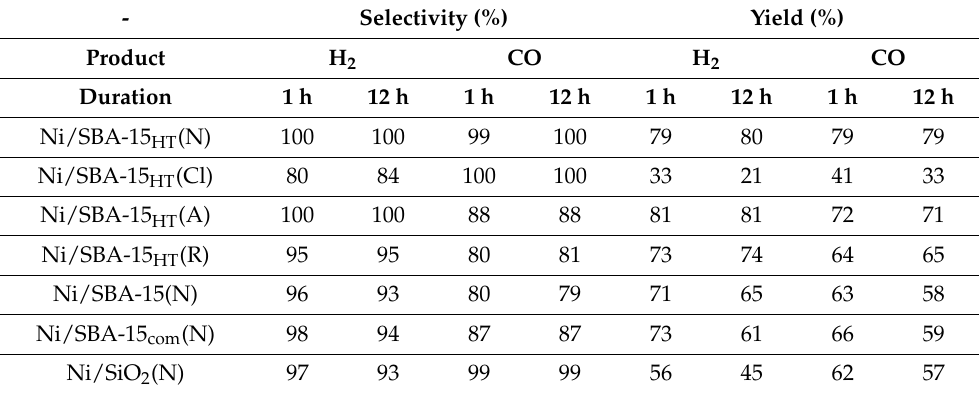
Table 3. Products selectivity and yield during stability measurements after 1 and 12 h on